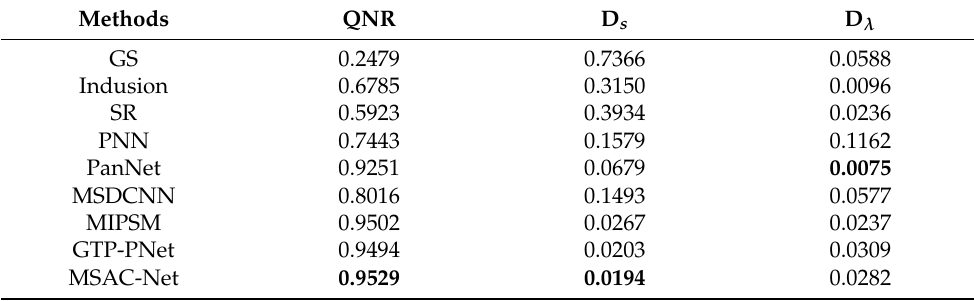
Table 9. Quality metrics of the different methods on the real IKONOS dataset.